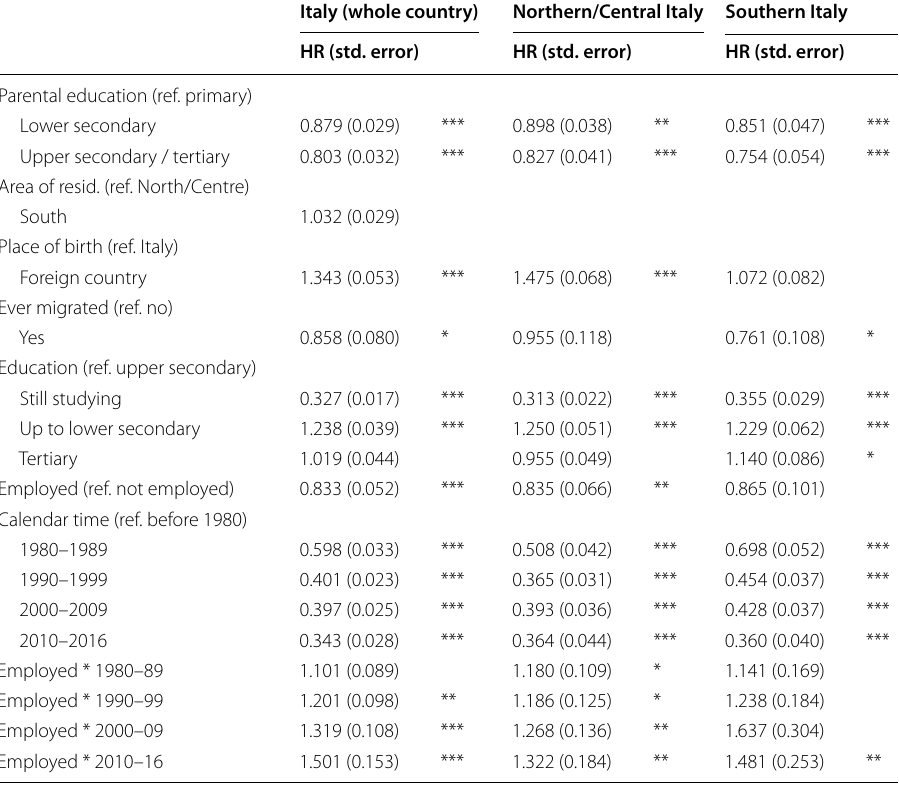
Table 3 Employment status and transition to motherhood over time. Cox models, HRs are reported with standard errors in